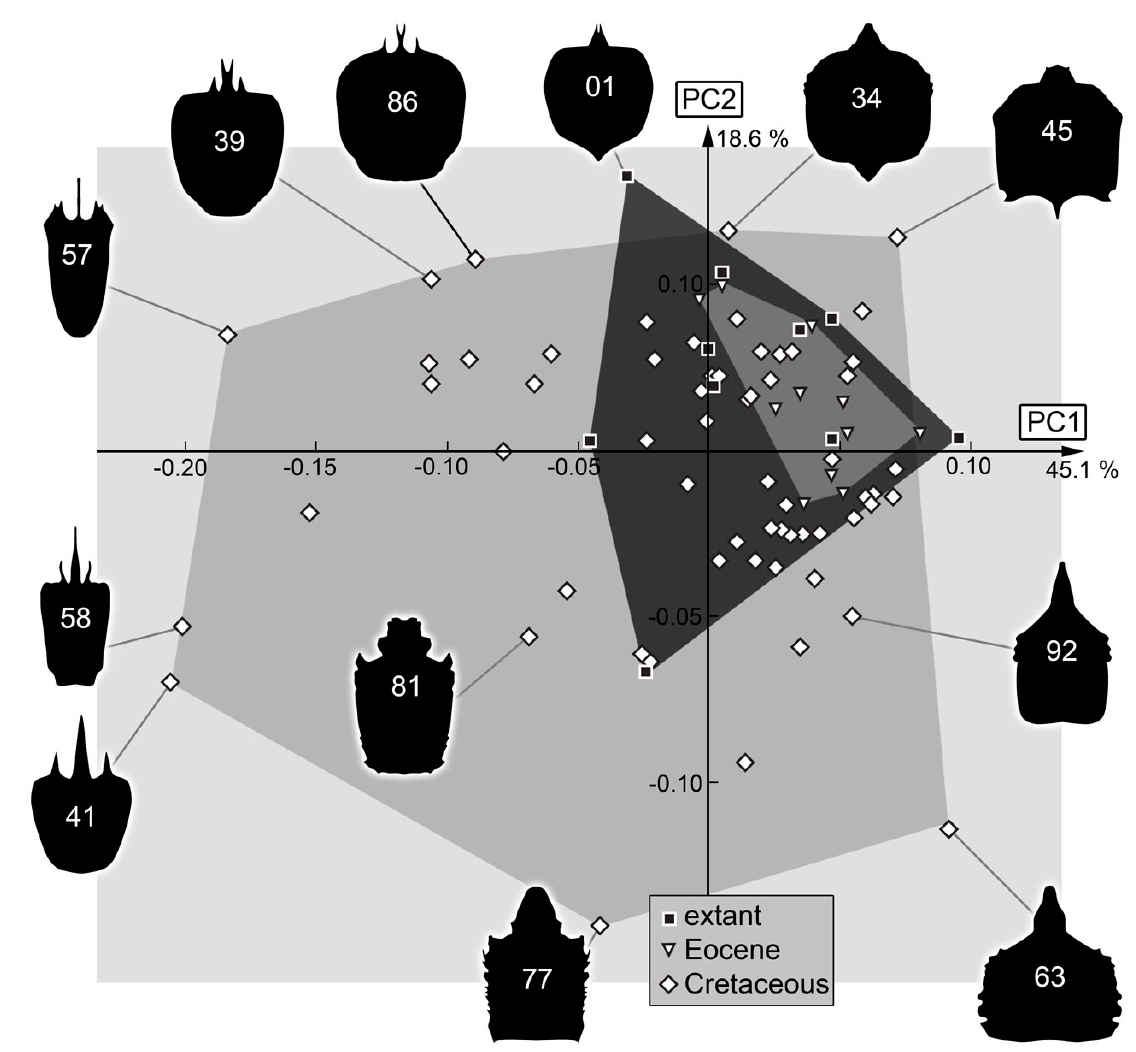
Figure 34. Scatterplot of PC2 vs. PC1 values of head capsule shapes (see Supplementary Materials File S2 for details).